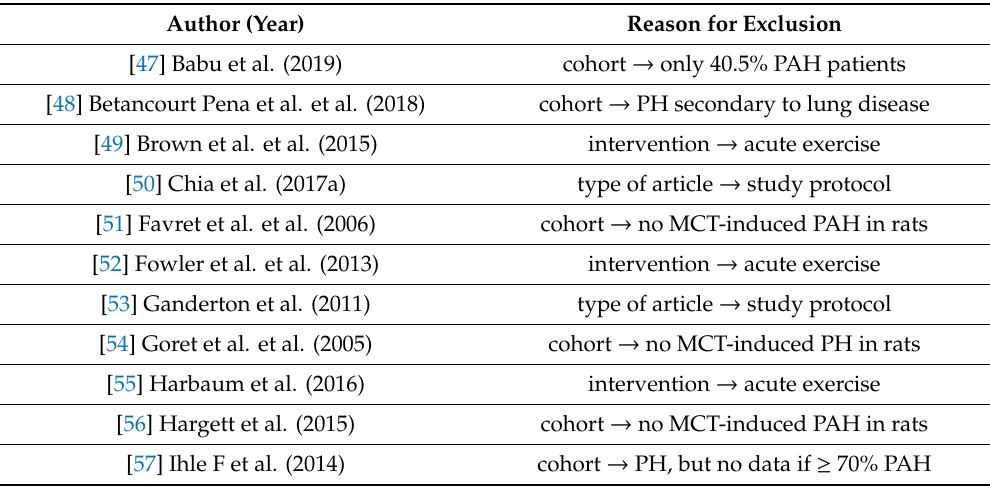
Table 3. Excluded studies with named reason ( n =